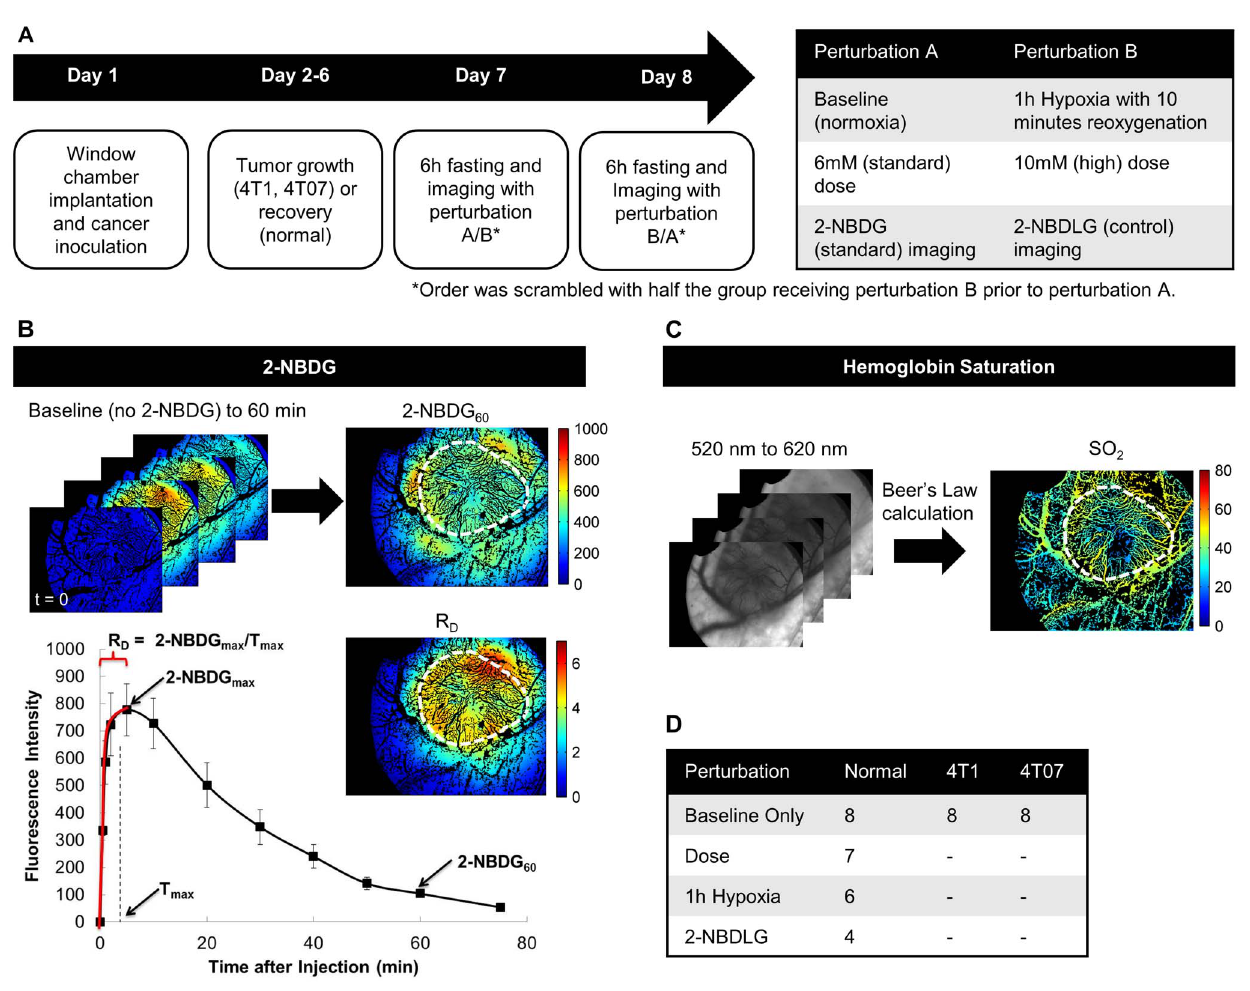
Fig. 1. Outline of methods. (A) Timeline of imaging events. Mice that were imaged under two imaging conditions were imaged on subsequent days. The order of imaging was scrambled to minimize order effects. (B) A 6 mM injection of 2-NBDG was given and imaged for at least 60 minutes, and the mean of the tumor region for each image was used to construct a kinetic curve. Images for the endpoints 2-NBDG 60 (2-NBDG intensity at 60 minutes) and the rate of delivery of 2-NBDG (R D 5 2-NBDG 60 /T max ) are shown. (C) Trans-illumination images were collected in 10 nm increments from 500–600 nm and used to calculate hemoglobin saturation (SO2). (D) The table shows the number of mice used in each perturbation group. Each mouse was used for up to two imaging sessions, with 24 hours between sessions. The groups were randomized to minimize bias from imaging order, and an analysis of variance (ANOVA) was performed to test for order effects. No significant imaging order effect was observed for any